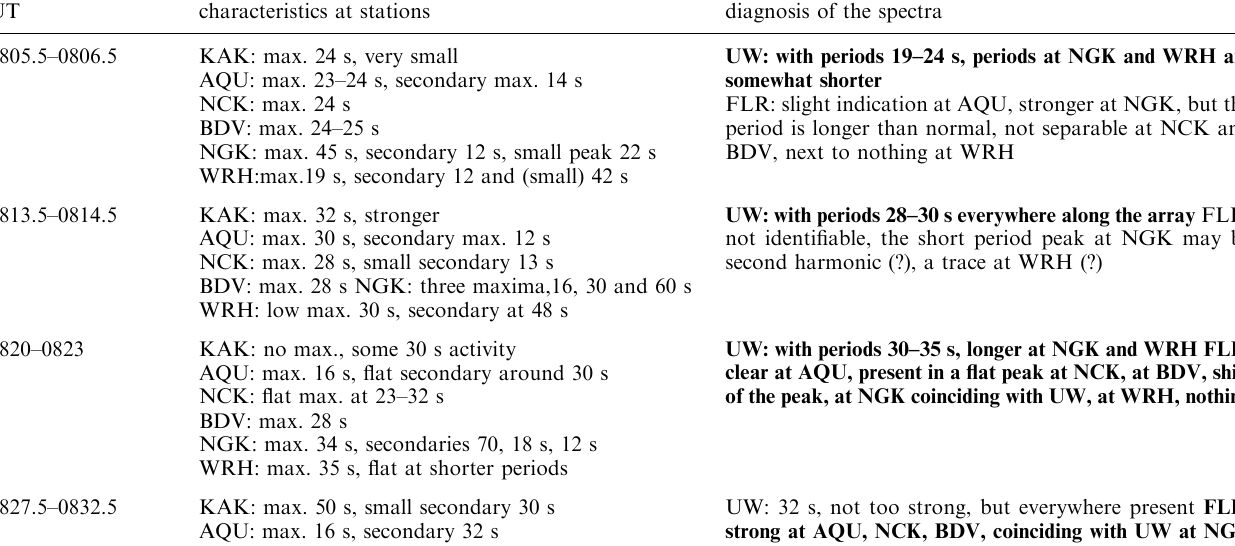
Table 1. Characteristics of the pulsations in selected short intervals: bold face indicates dominant types, In the case of 0806, 0814 and 0853 UT, instantaneous amplitudes were used, but due to the length of the filter, the sampled interval is in the critical period range about 1 min long, as indicated UT characteristics at stations diagnosis of the